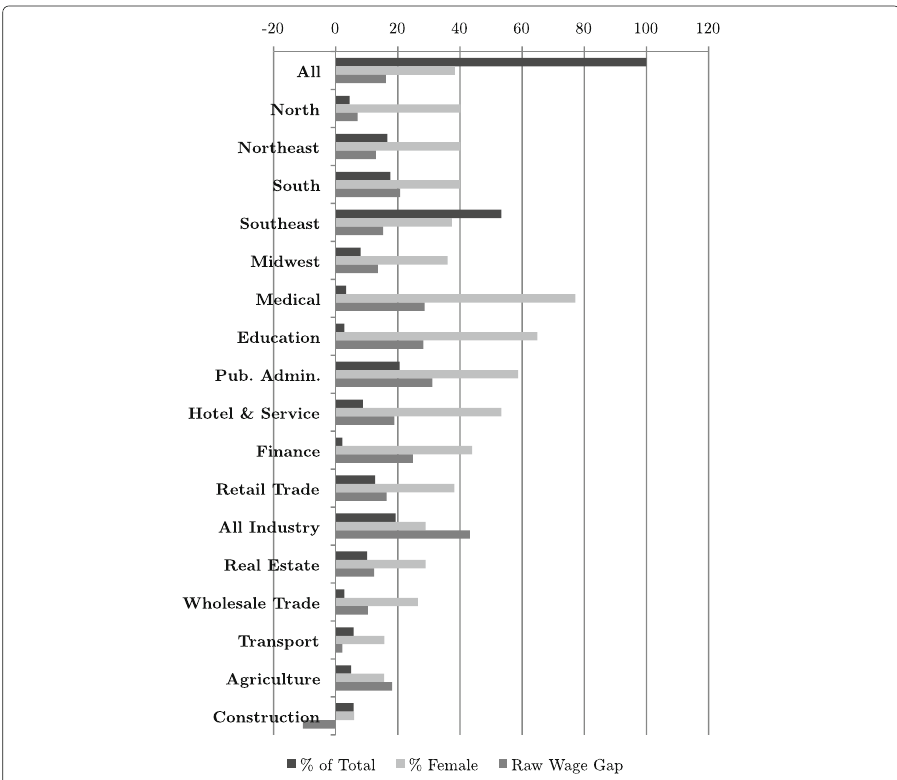
Fig. 1 Female distribution and wage gap, by region and sector. Source: Brazilian RAIS , 2001. Observations of employed, formal-sector workers ages 20–49 years. N =